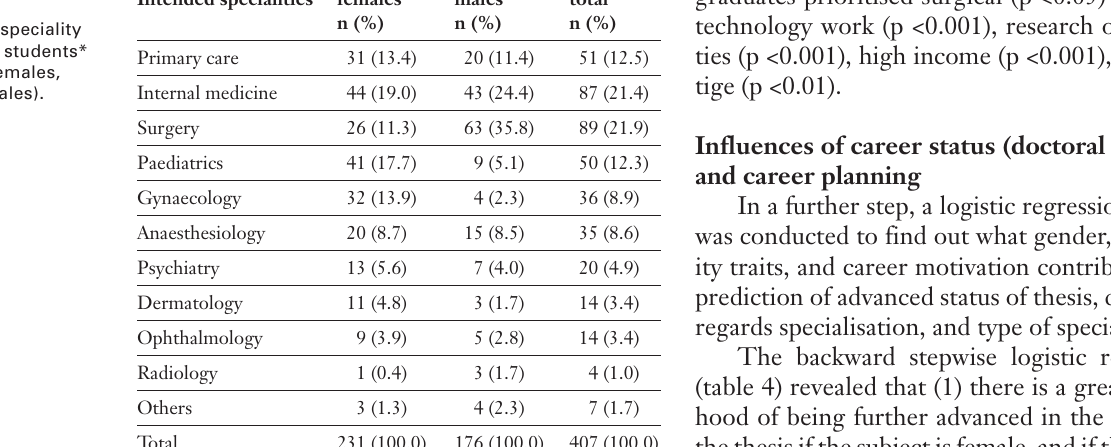
Choice of speciality of n = 407 students* (n = 231 females, n = 176 males).